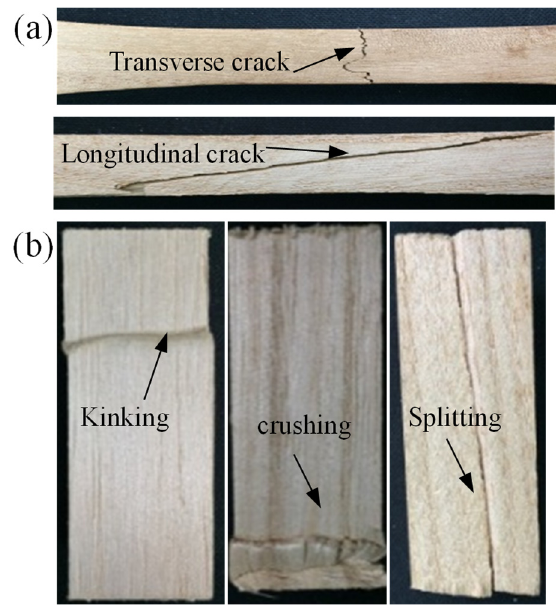
Figure 4. Typical failure modes of specimens under ( a ) tension and ( b ) compression. Table 2. Summary of failure modes of the tested specimens.